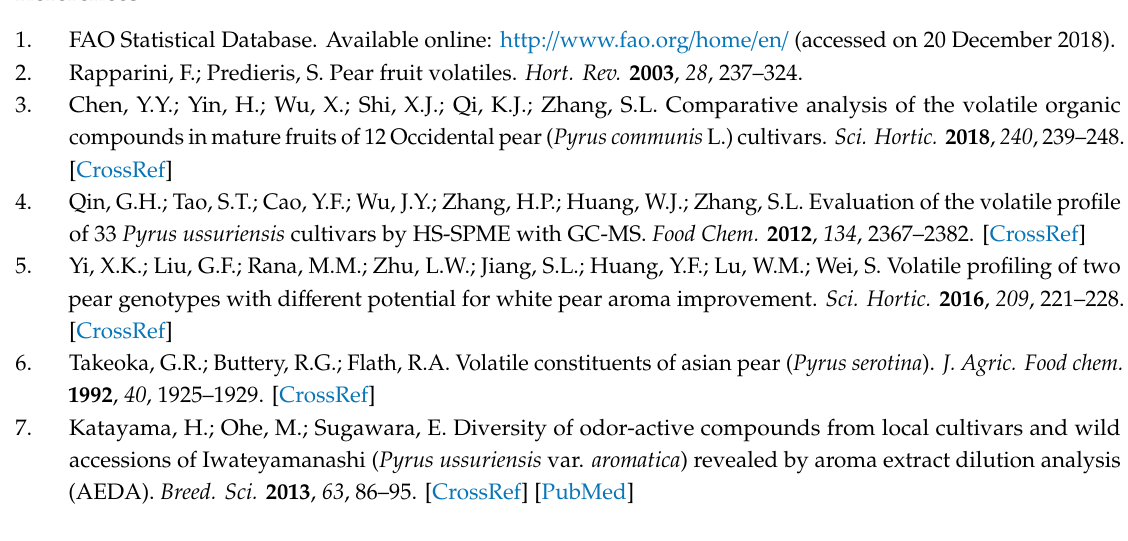
Figure S3: 2D chromatogram (total ion chromatography) of D Jules, Figure S4: 2D chromatogram (total ion chromatography) of Clapp, Figure S5: 2D chromatogram (total ion chromatography) of Stark, Table S1: The peak numbers of di ff erent classes obtained using 4 SPME fibres, Table S2: Concentrations of volatile compounds in pear